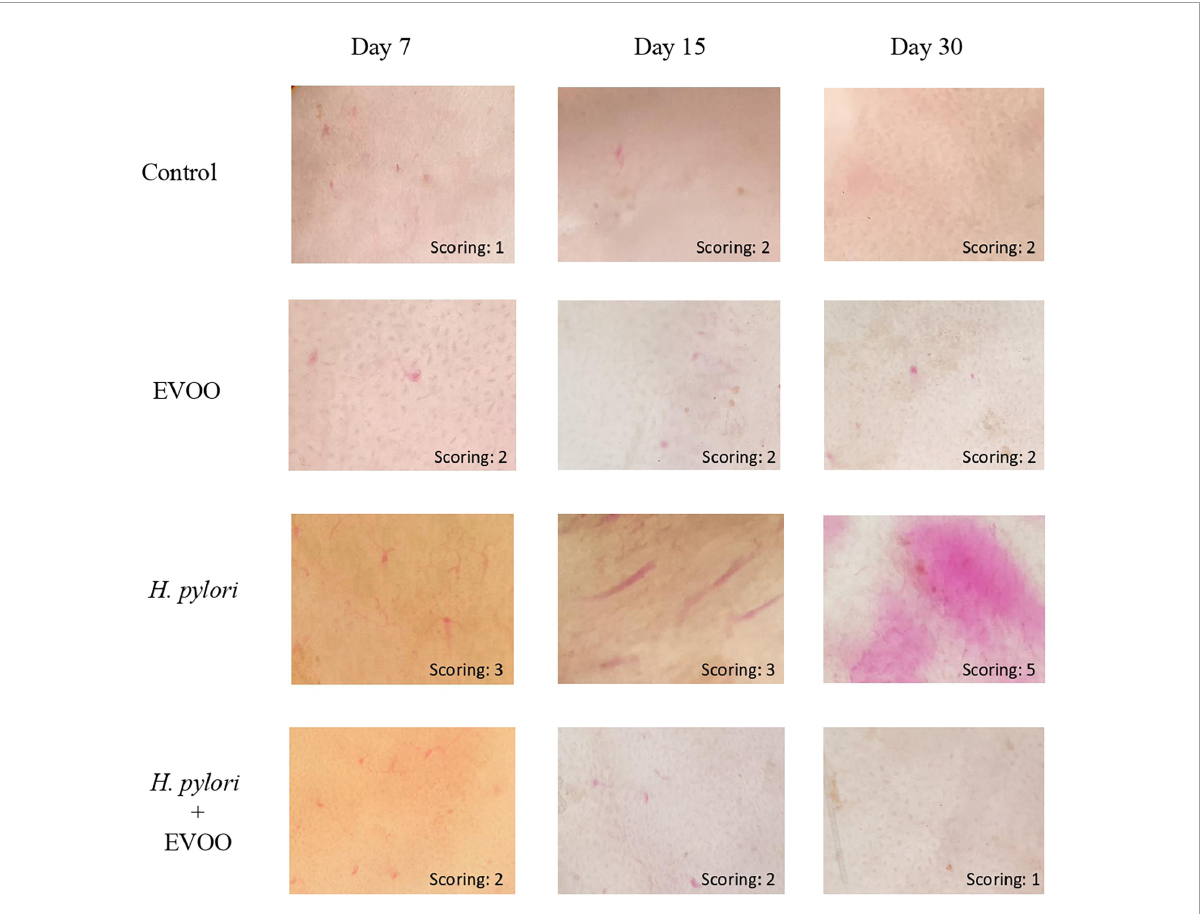
FIGURE4 Macroscopic evaluation of the gastric mucosa surface of mice after 7, 15, or 30 days of treatment from four experimental groups: (1) Control, (2) Extra virgin olive oil (EVOO), (3) Helicobacter pylori , and (4) EVOO + H. pylori . Gastric mucosa from the control and EVOO groups shows a healthy appearance, with a score of 1 and 2 (control) and 2 (EVOO) at different infection times. Helicobacter pylori group had an increasing scoring with the time, reaching the highest value at 30 days, while in the group infected and treated with EVOO, the gastric mucosa structure is similar to that of the control and EVOO